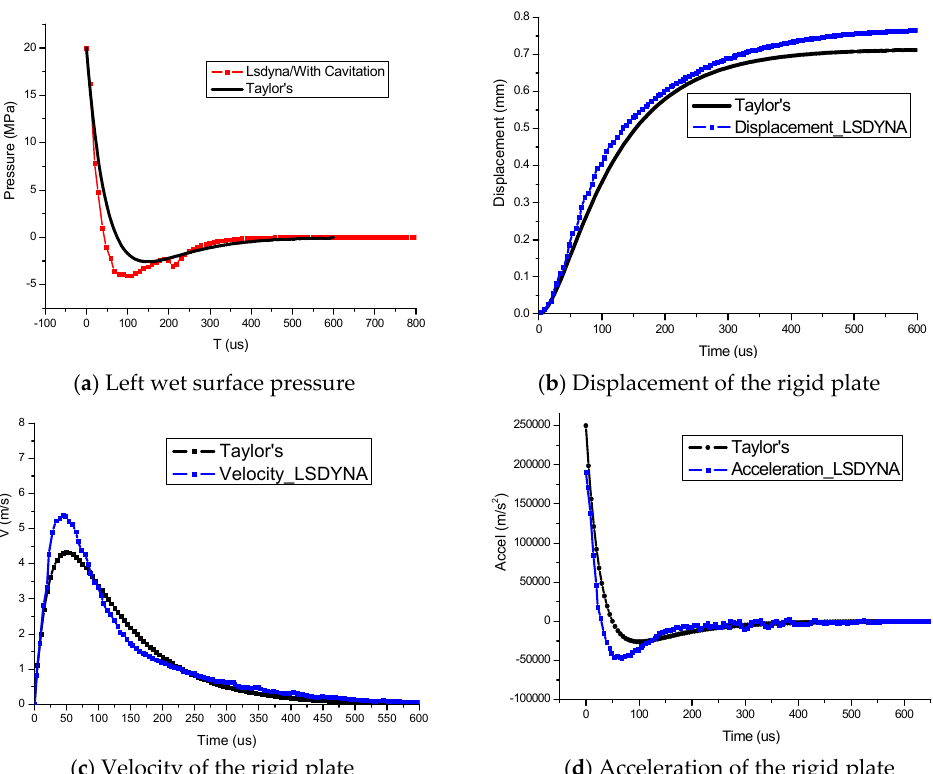
Figure 14. Comparison between the results of Taylor’s analytical solution and that of LSDYNA.